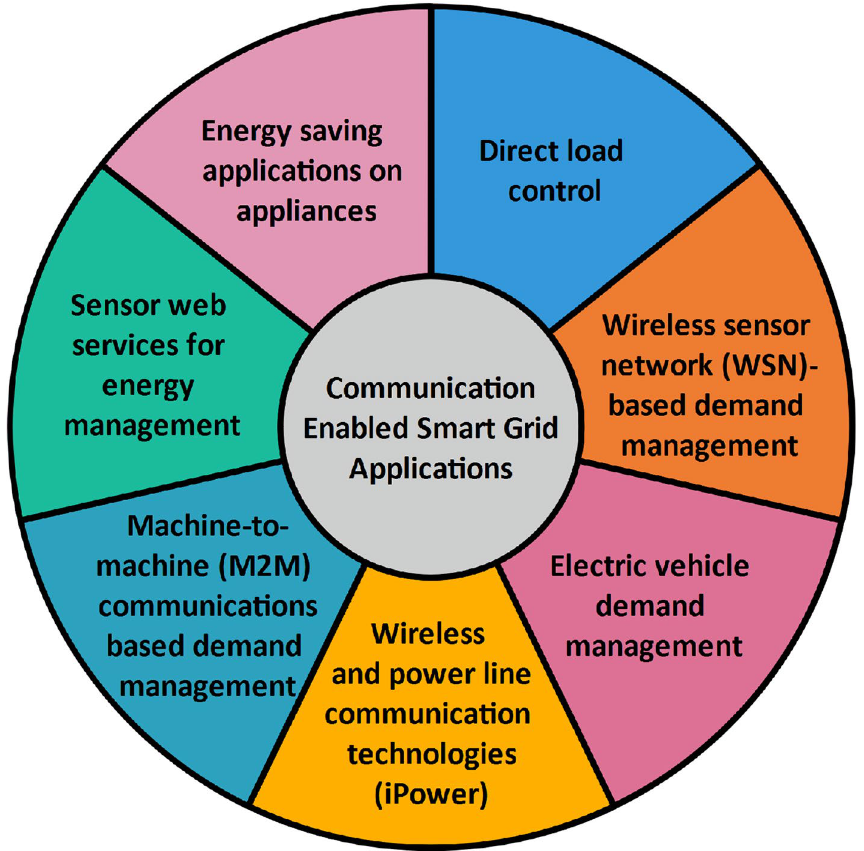
Figure 2. Communication enabled smart grid